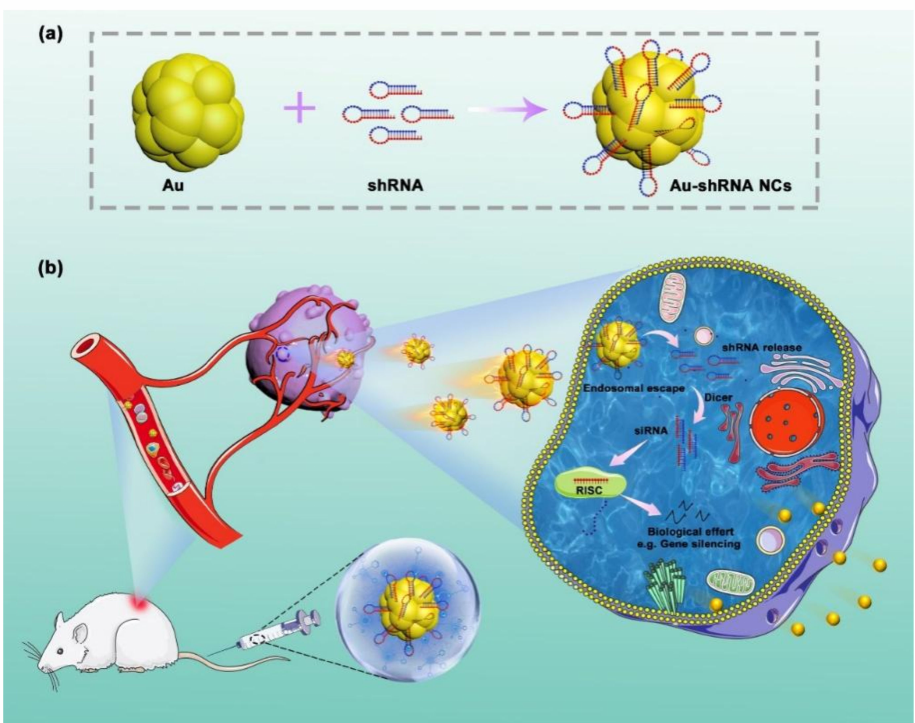
Figure 1. Schematic illustration of the in situ bio-self-assembled fluorescent Au–shRNA NCs to achieve biological effects for cancer imaging and